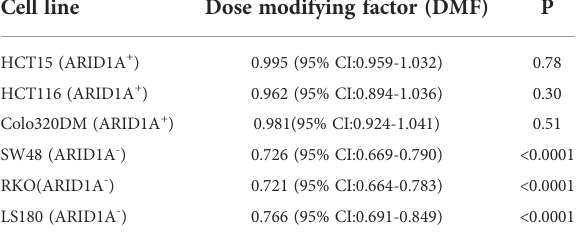
TABLE 1 Radiosensitizing effect of ATRi (VE822) for ARID1A + and ARID1A - colon cancer cell lines from the clonogenic